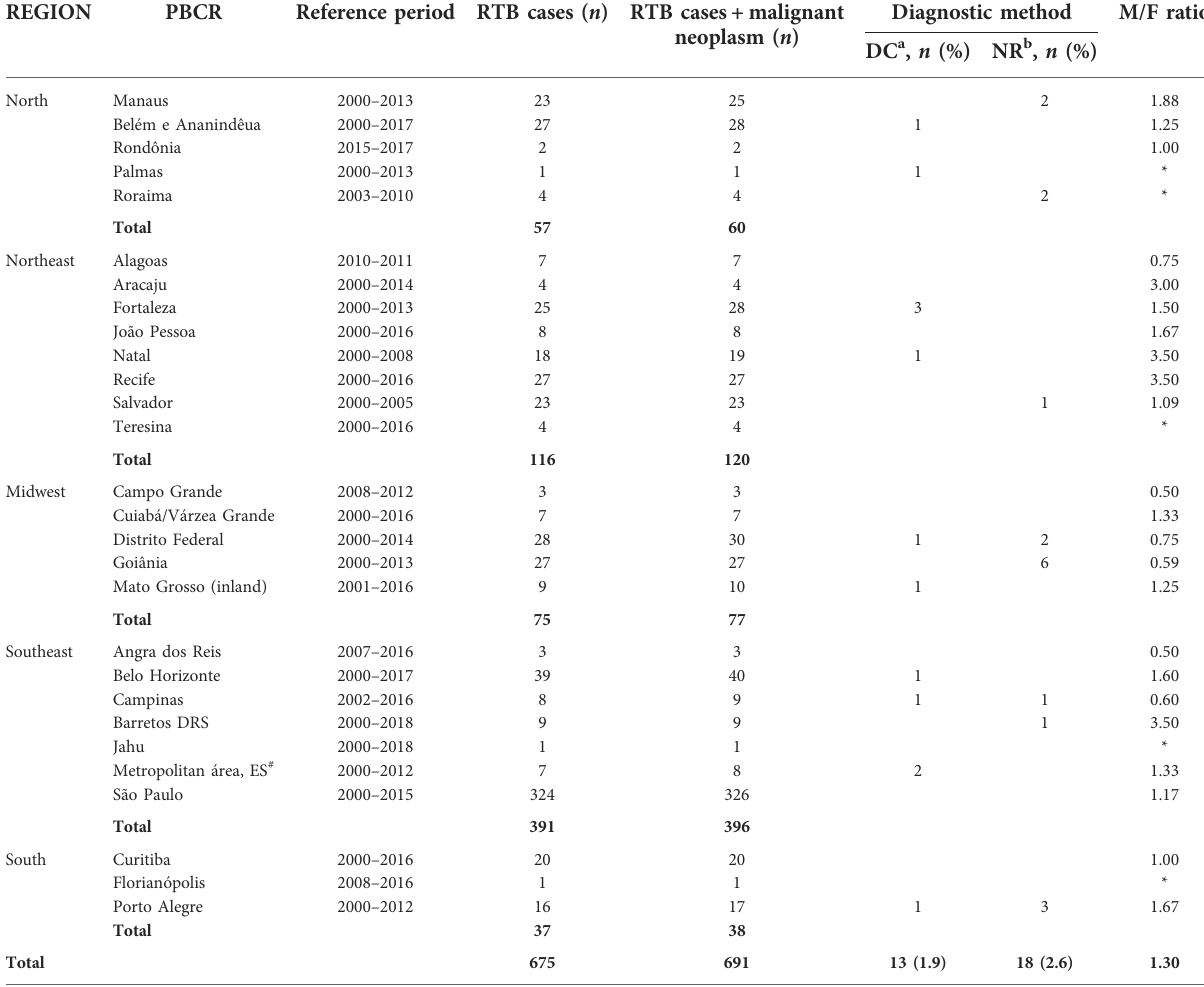
TABLE 4 Quality indicators of Population-Based Cancer Register (PBCR) for cases of retinoblastoma in children and adolescents aged 0 to 19 years from the year 2000, National Cancer Institute, Ministry of Health, Brazil.